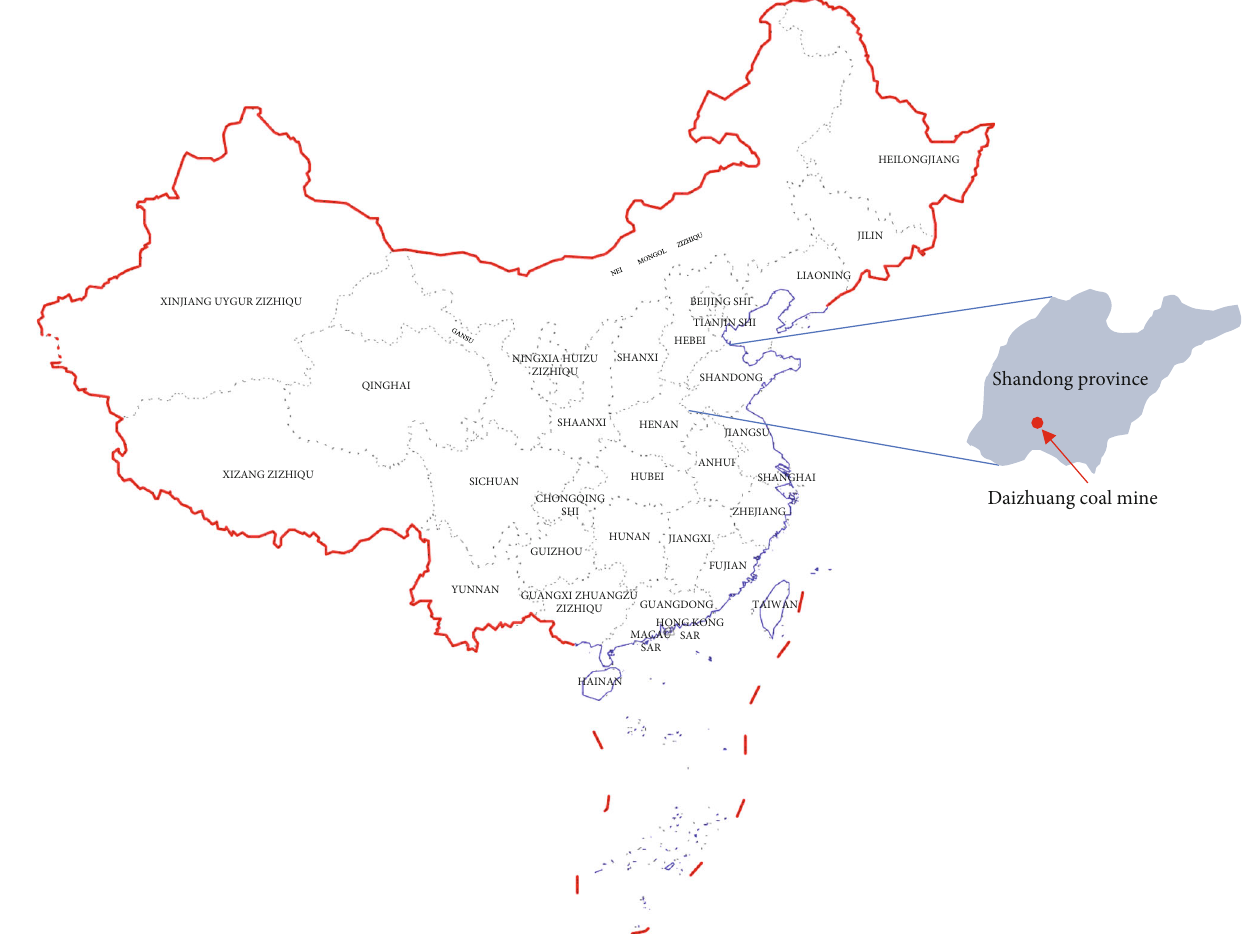
Figure 1: The location of Daizhuang Coal Mine.